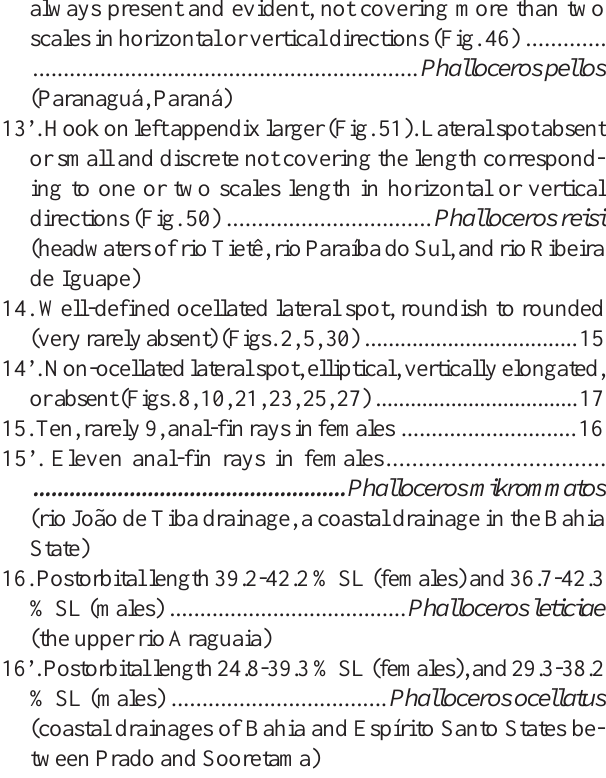
Fig. 52. Urogenital region of female of Phalloceros spiloura , MCP 29270. (A) ventral view; (B) lateral view of right side. A = anus; AF = anal fin; PF = pelvic fin; UGO = urogenital opening; UGP = urogenital papilla. Scale bar 1 mm.